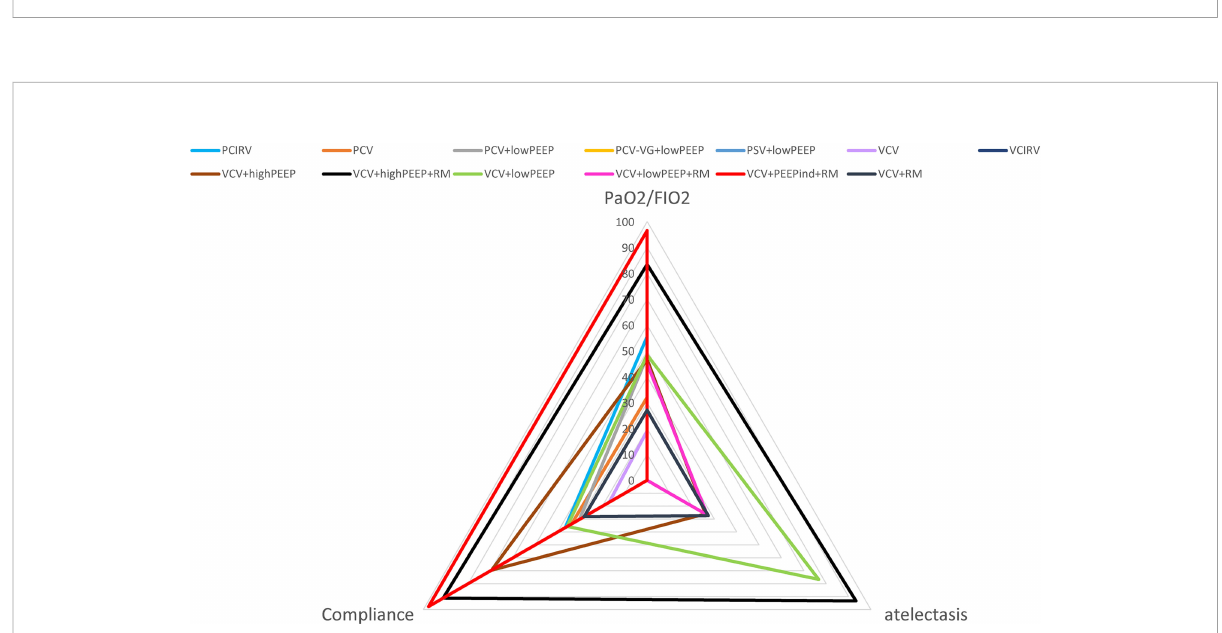
FIGURE 6 SUCRA ranking of the results in this